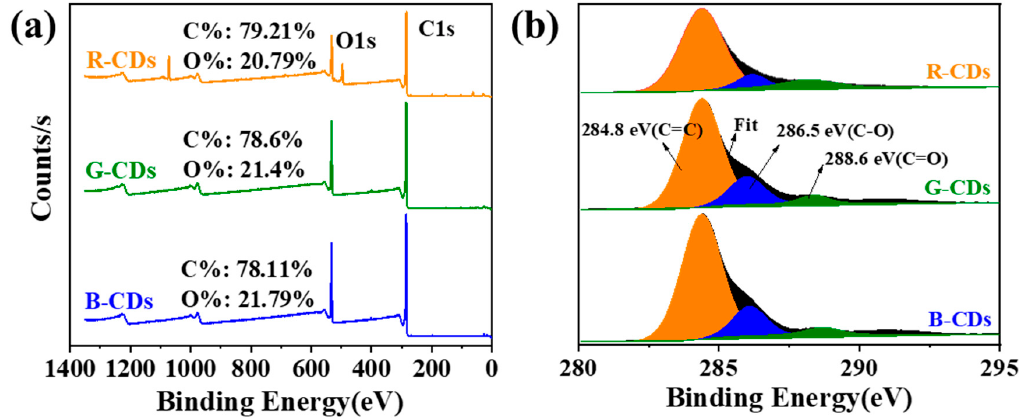
Figure 4. ( a ) Photoluminescent decays. ( b ) FT–IR spectra of R-CDs to B-CDs in ethanol.